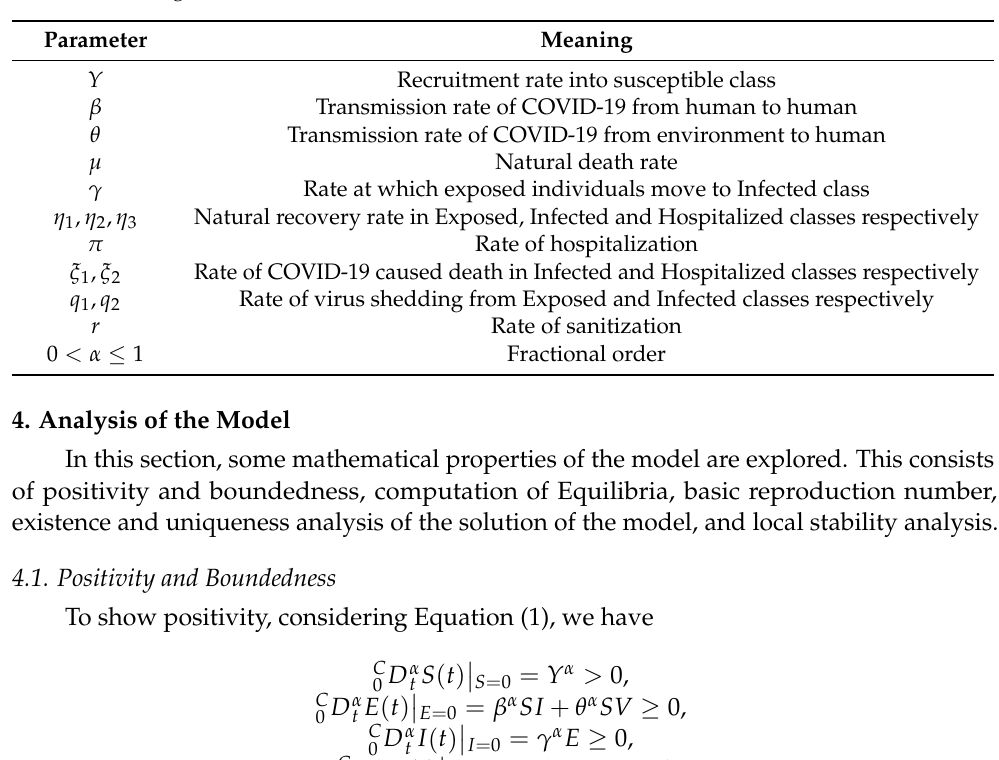
Table 1. Meaning of